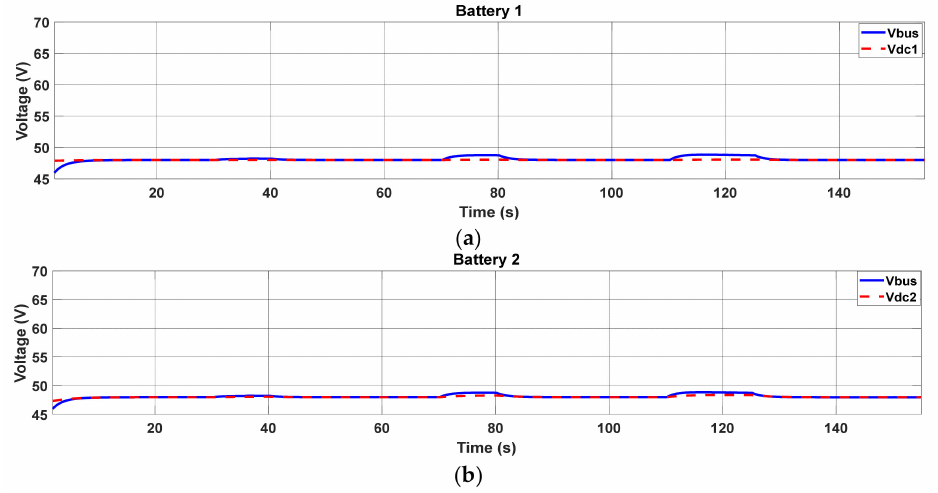
Figure 14. DC bus voltage control with distributed secondary control for voltage restoration for